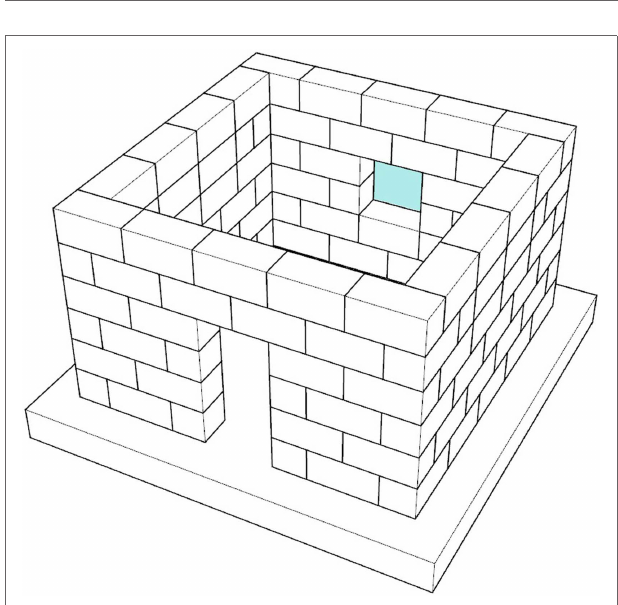
FIGURE 4 | The considered gabion box walls